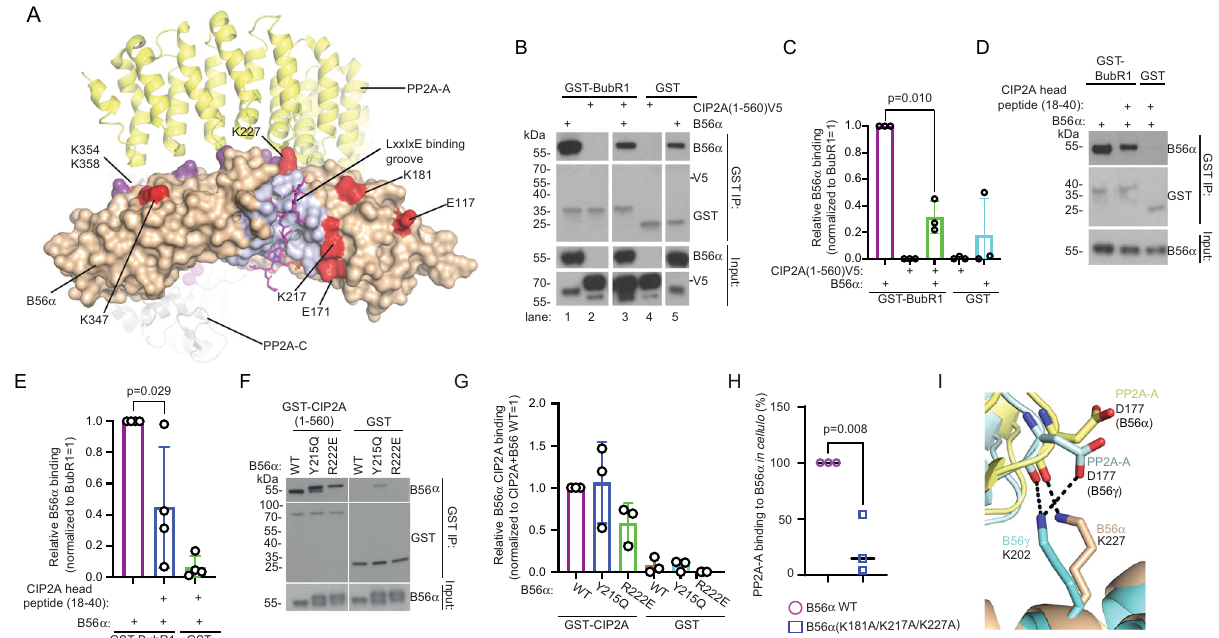
Fig. 5 | CIP2A mutes LxxIxE-motif substrate binding of B56 α . A Sites of CIP2A- B56 α cross-links(inred;PDB:6NTS)mappedinrelationtoindicatedLxxIxE-binding groove of B56 α . Residues indicated in light purple constitutes the LxxIxE-binding region of B56 α between amino acids 212-271. Residues in dark purple indicate aminoacidsinvolvedinPP2A-AinteractionasexplainedinFig.4. B CIP2A(1-560)V5 out-competes prototypical LxxIxE motif target BubR1(LxxIxE peptide 647-720) fromitsdirectassociationwithB56 α .SourcedataareprovidedasaSourceData fi le. C Quanti fi cation of GST pull-down data from ( B ) shown as a mean + S.E.M from N =3 biological repeats. Two-sided t-test. D B56 α competition assay using GST- BubR1(647-720) alone, or in combination with CIP2A N-terminal head peptide (aa. 18-40). Source data are provided as a Source Data fi le. E Quanti fi cation for data fromDshownasamean+S.E.Mfrom N =4biologicalrepeats.Two-sidedt-test. F In vitrobinding assayusingpuri fi edrecombinant GST-tagged CIP2A(1-560) and B56 α WT or B56 variants Y215Q and R222E, which contain mutations that prevent